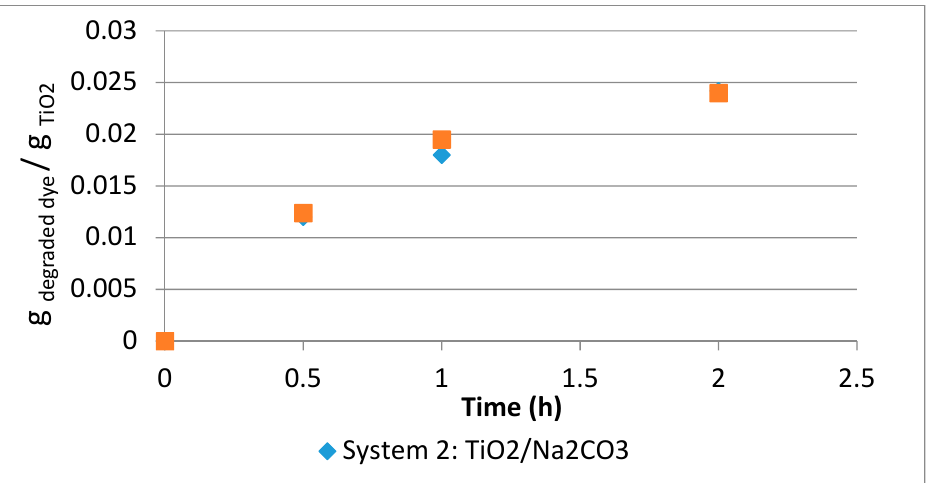
Figure 15. Comparison of the dye degradation curves for Systems 1 and 2. Environments 2019 , 6 , x FOR PEER REVIEW